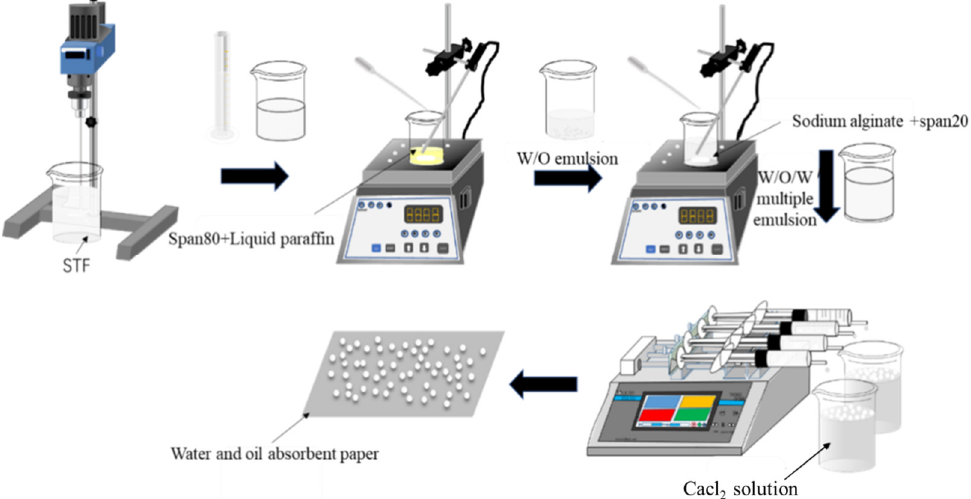
Figure 1. Schematic manufacturing procedure of shear thickening fluid (STF) capsules.